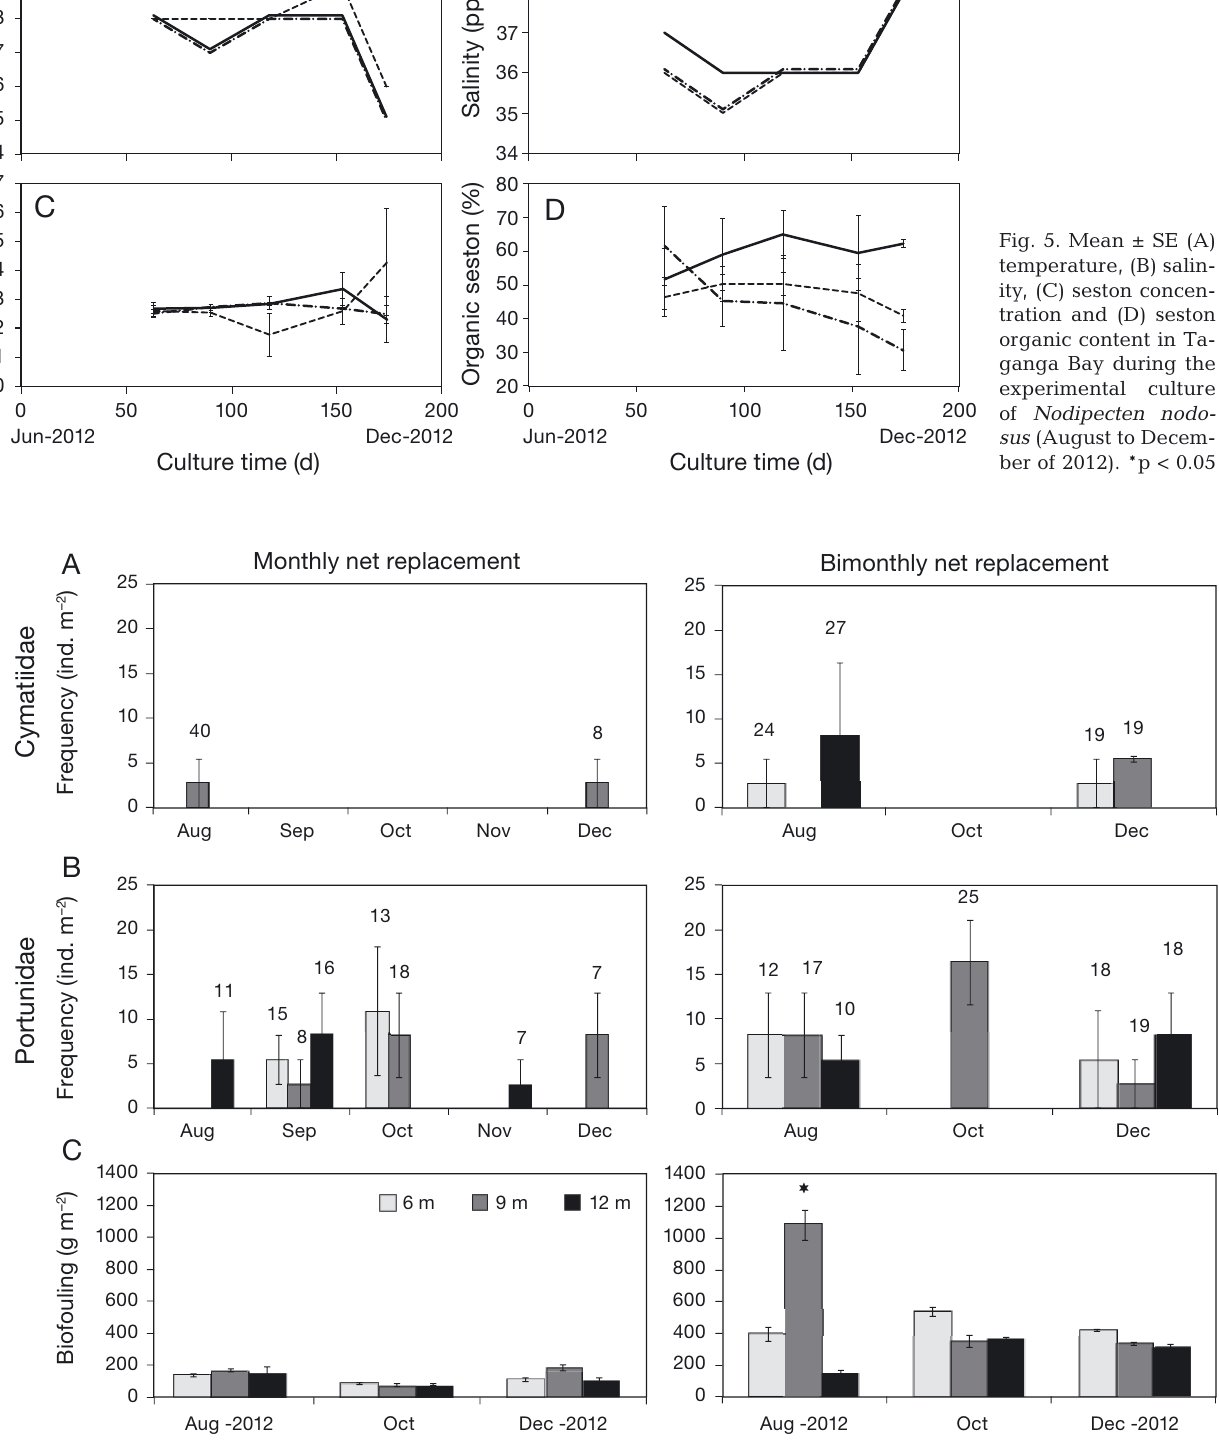
Fig. 6. Mean ± SE frequency of presence and size of the predators (A) Cymatiidae and (B) Portunidae inside the pearl nets with Nodipecten nodosus and (C) biofouling dry biomass in the nets under different conditions (i.e. culture depths and net re- placement frequencies). Numbers above bars represent the predator size means in mm (shell length for cymatid snails and carapace width for portunid crabs). *p <